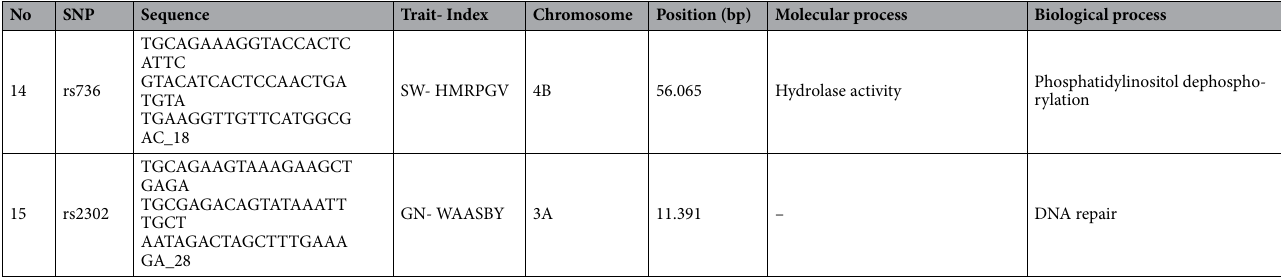
Table 4. Description and annotation of identified markers ( P < 0.0001). GY grain yield, SW spike weight, GN grain number.